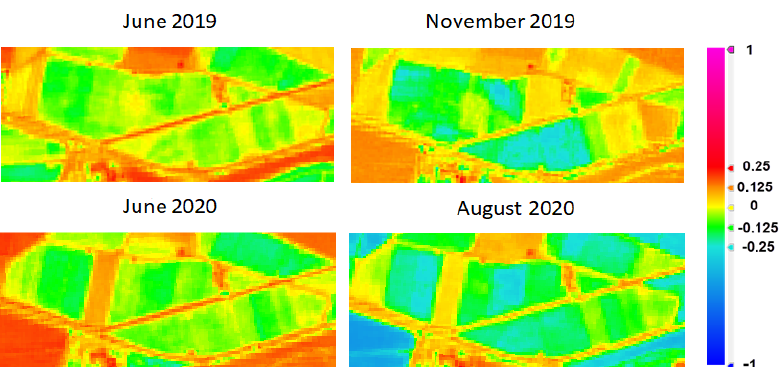
Figure 15. BSI index evolution in stone fruit tree farms.